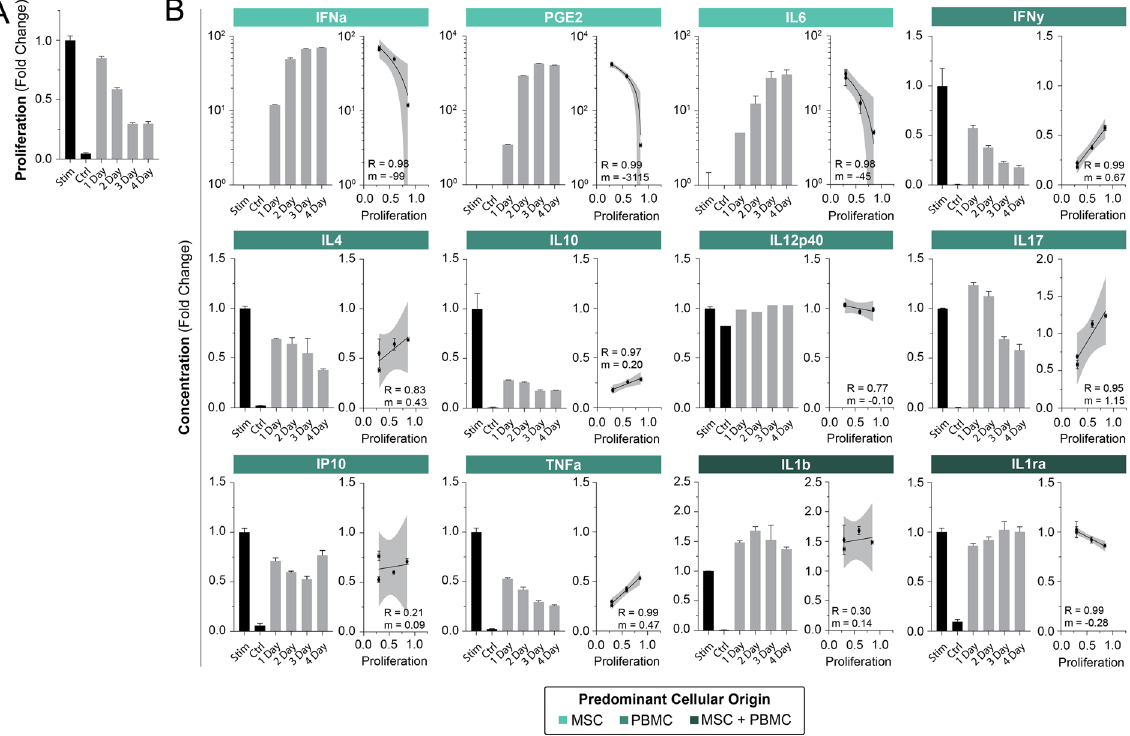
Figure 3. PBMC culture duration with MSCs is critical to overall immunosuppressive effect. PBMC proliferation was attained through stimulation with ConA and IL2 for a period of 4 days. MSC transwell inserts were removed after 1, 2, and 3 days co-culture initiation to time duration. Proliferation was measured through flow cytometry and CFSE staining; bar graphs and data points represent mean + / − SD of 3 samples. ( A ) Bar graphs of normalized proliferation versus time exposure to MSCs. ( B ) Bar graphs of normalized cytokine secretion versus time exposure to MSCs. Investigating cytokine profiling, we see concordant associations seen in previous sections. Longer exposure to MSCs results in greater suppression of inflammatory cytokines and vice versa for short exposures. Correlative lines were generated using a linear